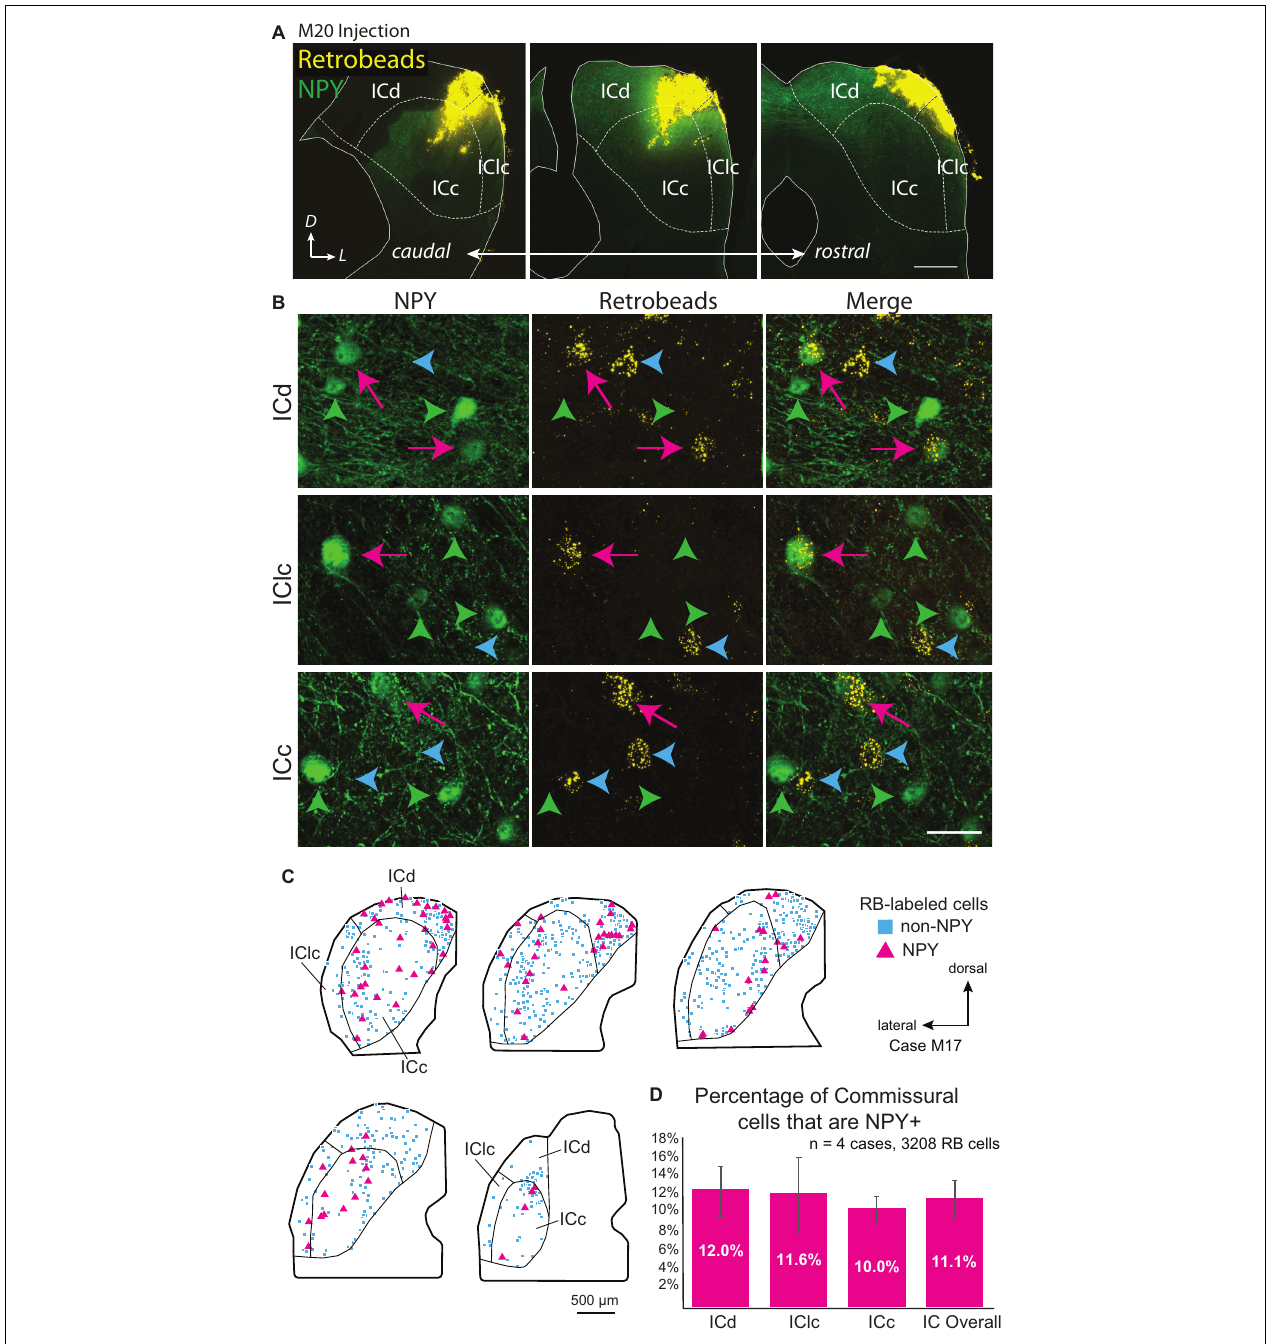
FIGURE 1 | Deposits of retrograde tracer across multiple inferior colliculus (IC) subdivisions label NPY+ and NPY-negative (“non-NPY”) commissural cells in all subdivisions of the contralateral IC. (A) Three images in a caudal to rostral sequence showing a deposit of Retrobeads (RB, yellow) in the right IC that included parts of the central IC (ICc), dorsal cortex (ICd), and lateral cortex (IClc). The injection was made in an NPY-hrGFP mouse so NPY is green. Scale bar = 0.5 mm. (B) High magnification images show cells in the left IC that were labeled by an injection of RB in the right IC. Examples are shown from the dorsal cortex (ICd, top row), lateral cortex (IClc, middle row), and central nucleus (ICc, bottom row). In each row, the first column shows NPY-hrGFP label and the second column shows RB labeling in the same field of view (merged view in the third column). RB-labeled cells could be double labeled with NPY (magenta arrows) or could be NPY-negative (“non-NPY”, cyan arrowheads). Also present are NPY+ cells that did not contain RB (green arrowheads). Scale bar = 25 µ m. (C) Plots showing the distribution of RB-labeled commissural cells in a series of transverse sections. A majority of RB-labeled neurons were non-NPY (cyan); NPY+ commissural cells (magenta) were interspersed among the non-NPY cells throughout the IC. (D) Graph showing the average percentage of RB-labeled (i.e., commissural) cells that were NPY+ in the IC overall and in each of the major subdivisions across four cases. NPY cells contribute roughly 10%–12% of the commissural projection. Error bars = SD.